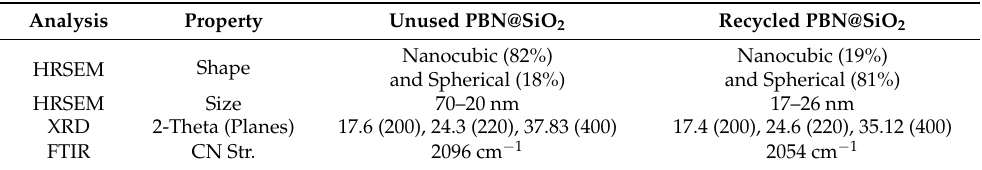
Figure 12. Analysis of recycled PBN@SiO 2 following acid treatment. ( A ) An alteration in nanoparticle morphology as identified through SEM imaging, ( B ) A decrease in particle size (26 nm) as calculated from the displayed histogram, ( C ) Minor shift in peak position with similar planes as identified through XRD analysis, ( D ) Spectrum with the entire anticipated element as detected by EDX, ( E ) Shift in CN stretching peak observed using FTIR. Table 4. Table with HRSEM, XRD and FTIR data displaying the variations between unused and recycled PBN@SiO 2 .